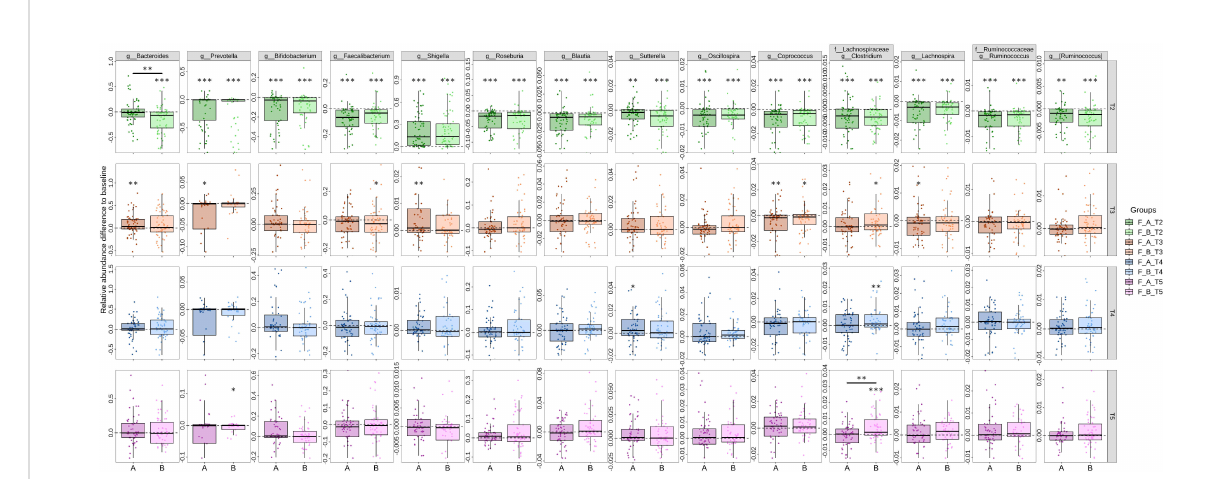
FIGURE 3 Dynamic alterations of genus-level gut microbiota after different periods of H. pylori eradication. 14 most abundant genera that differed between T1 and T2 were identi fi ed, and their alterations from T2 to T5 were calculated based on their abundance relative to T1. Value that lower than zero represents reduced relative abundance compared to baseline, whereas higher than zero represents increased relative abundance. *, p<0.05; **, p<0.01; ***, p<0.001; star without a line, group compared to T1; star with a line, comparison between (A, B) . (A) probiotics group; (B) placebo group; T1, pretreatment; T2, cessation of quadruple therapy; T3, 2 weeks after quadruple therapy; T4, 8 weeks after quadruple therapy; T5, 24 weeks after quadruple therapy.